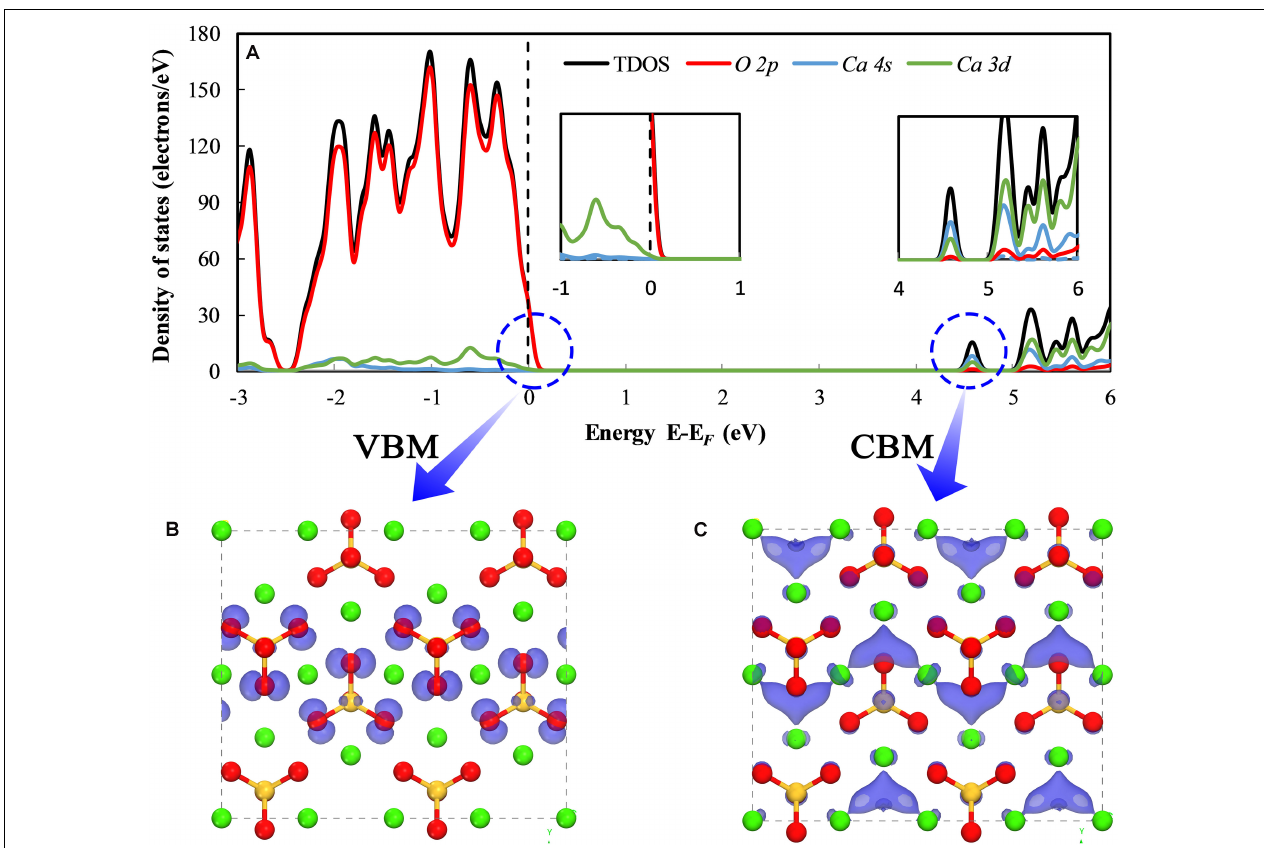
FIGURE 2 | The density of states (A) and local charge density distribution of the valence band maximum (B) and conduction band minimum (C) of pure γ -Ca 2 SiO 4 . The green, orange, and red spheres are Ca, Si, and O atoms, respectively. The blue translucent electron clouds represent the orbitals of energy band edges.